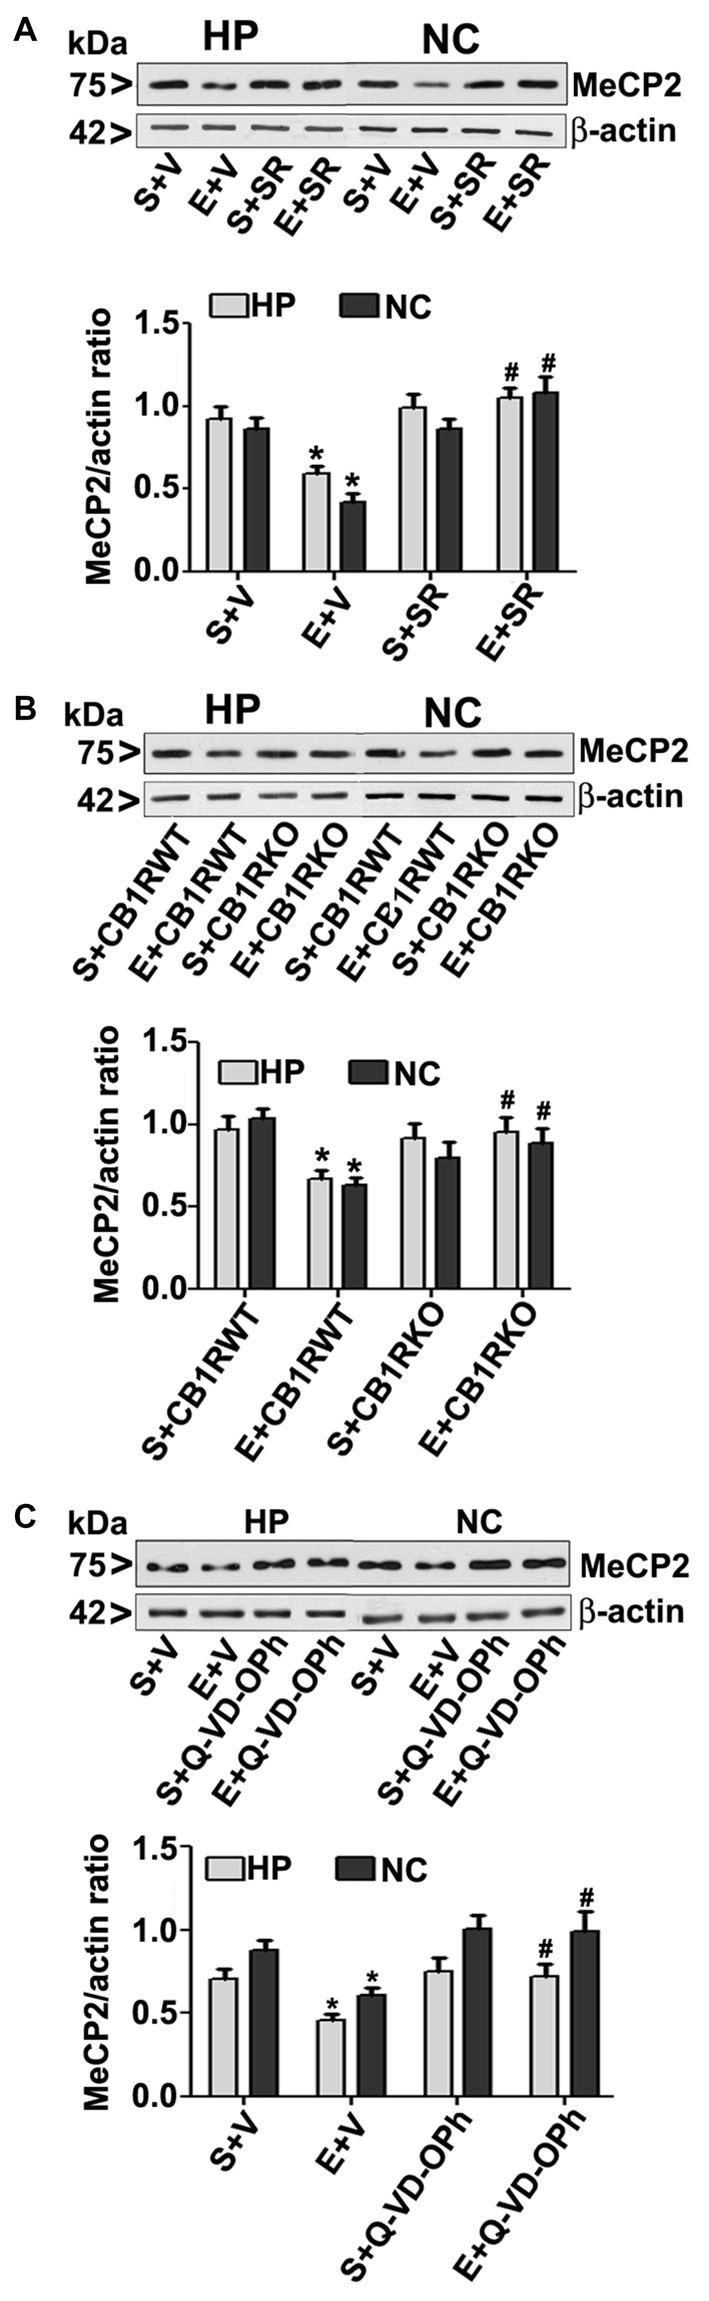
CB1R antagonist (SR141716A) or CB1R knockout (KO) mice or Q-VD-OPh protect against ethanol-mediated loss of MeCP2 proteins. (A) P7 mice were pretreated with SR (1 mg/kg) 30 min before saline or ethanol treatment. MeCP2 proteins from hippocampal (HP) and neocortical (NC) nuclear extracts from the four treatment groups (S + V, E + V, S + SR and E + SR) groups (n = 12 pups/group) were subjected to western blotting. S, saline; E, ethanol. β-actin was used as the protein loading control. (*p < 0.01 vs. S + V; #p < 0.01 vs. E + V). (B) P7 CB1R wild-type (WT) and CB1R KO mice were treated with saline or ethanol. From nuclear extracts of HP and NC, western blot analysis of MeCP2 protein was performed for all the four treatment groups (S + CB1R WT, E + CB1R WT, S + CB1R KO + and E + CB1R KO) groups (n = 12 pups/group). S, saline; E, ethanol. (*p < 0.01 vs. S + CB1RWT; #p < 0.01 vs. E + CB1RWT). (C) P7 mice pre-treated for 30 min with Q-VD-OPh (1 mg/kg) or vehicle were exposed to ethanol for 8 h, and MeCP2 protein levels were examined in nuclear extracts of the HP and NC from saline (S), ethanol (E), S + Q-VD-OPh, or E + Q-VD-OPh groups (n = 12 pups/group) via western blot analysis. β-actin was used as the protein loading control (*p < 0.01 vs. S; #p < 0.01 vs. E. Error bars, SEM (two-way ANOVA with Bonferroni’s post hoc test).